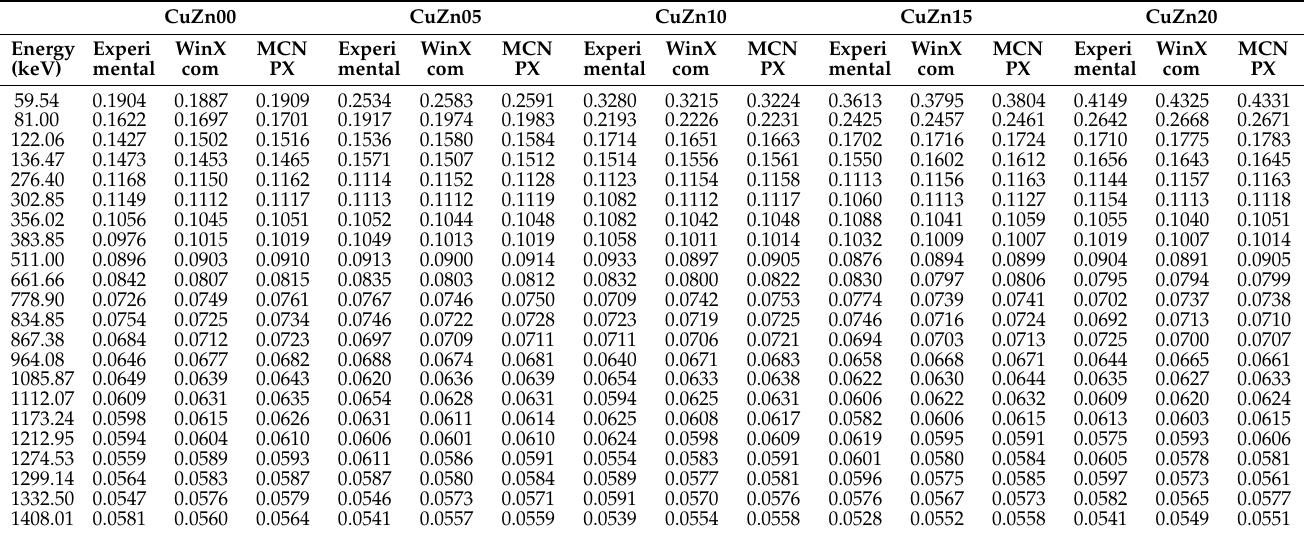
Figure 5. Mass attenuation coefficient ( µ m ) values as a function of photon energy and Cu-Zn content of samples. Table 2. Experimental, theoretical and Monte Carlo mass attenuation coefficients (cm 2 /g) results of brass reinforced